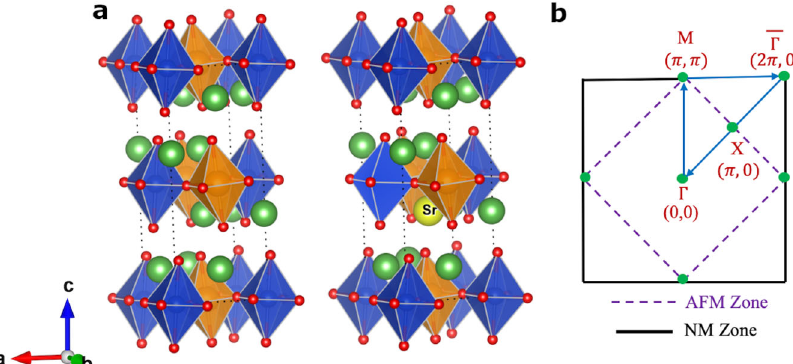
Fig. 1 LTO crystal structure and brillouine zone considered for the calculation. a Theoretically predicted crystal structure of La 2 − x Sr x CuO 4 in the LTO phase for x = 0.0 and 0.25. Copper, oxygen, lanthanum, and strontium atoms are represented by blue, red, green, and yellow spheres, respectively. Octahedral faces are shaded in blue (orange) to denote spin-up (down). Black dotted lines mark the unit cell. b A schematic of the non-magnetic (NM) and anti-ferromagnetic (AFM) Brillouin zone, where the path followed in the electronic dispersions in Fig. 6 is marked.